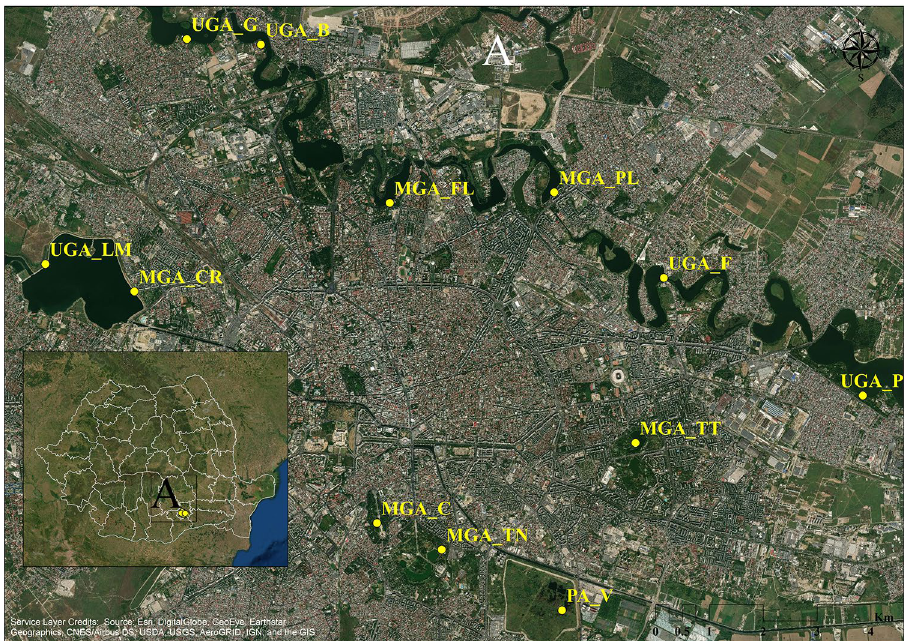
Figure 1. Geographical locations of the natural protected urban area (PA), managed (MGA) and unmanaged green areas (UGA) in Bucharest, investigated in 2017. Map created using ArcGIS software by Esri. ArcGIS and ArcMap are the intellectual property of Esri and are used herein under license. Copyright Esri. All rights reserved. For more information about Esri software, please visit www.esri.com.